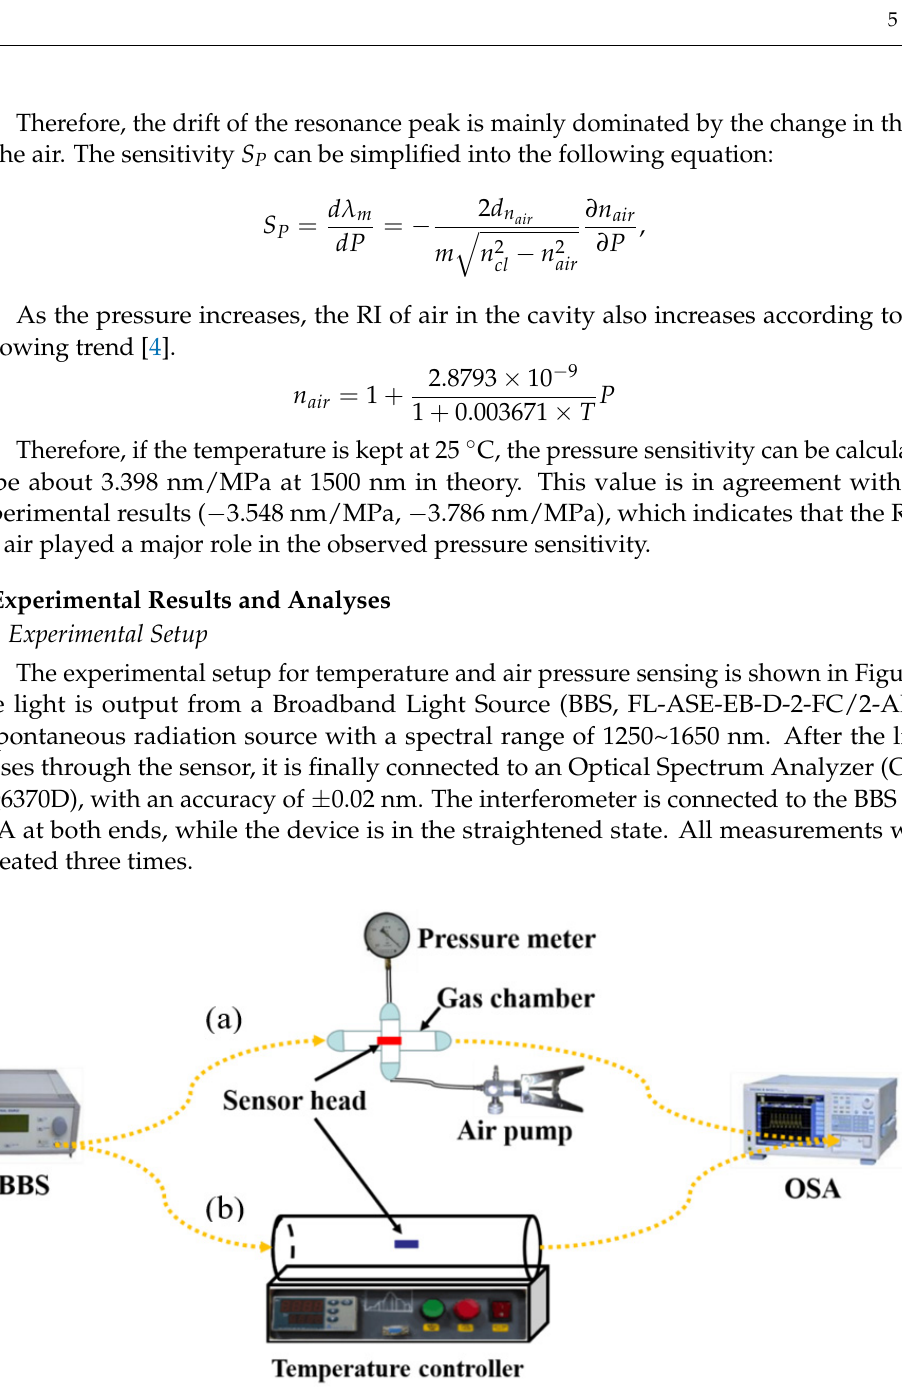
Figure 5. Schematic diagram of the experimental setup. ( a ) Air pressure sensing unit; ( b ) Temperature sensing unit.